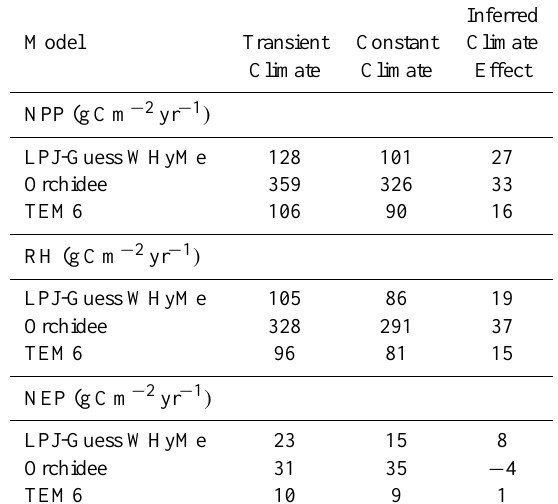
Table 8. Inferred climate effect of NPP, RH, and NEP for 1990– 2006 as the difference between simulations of the regional appli- cations of process models driven by transient climate and constant